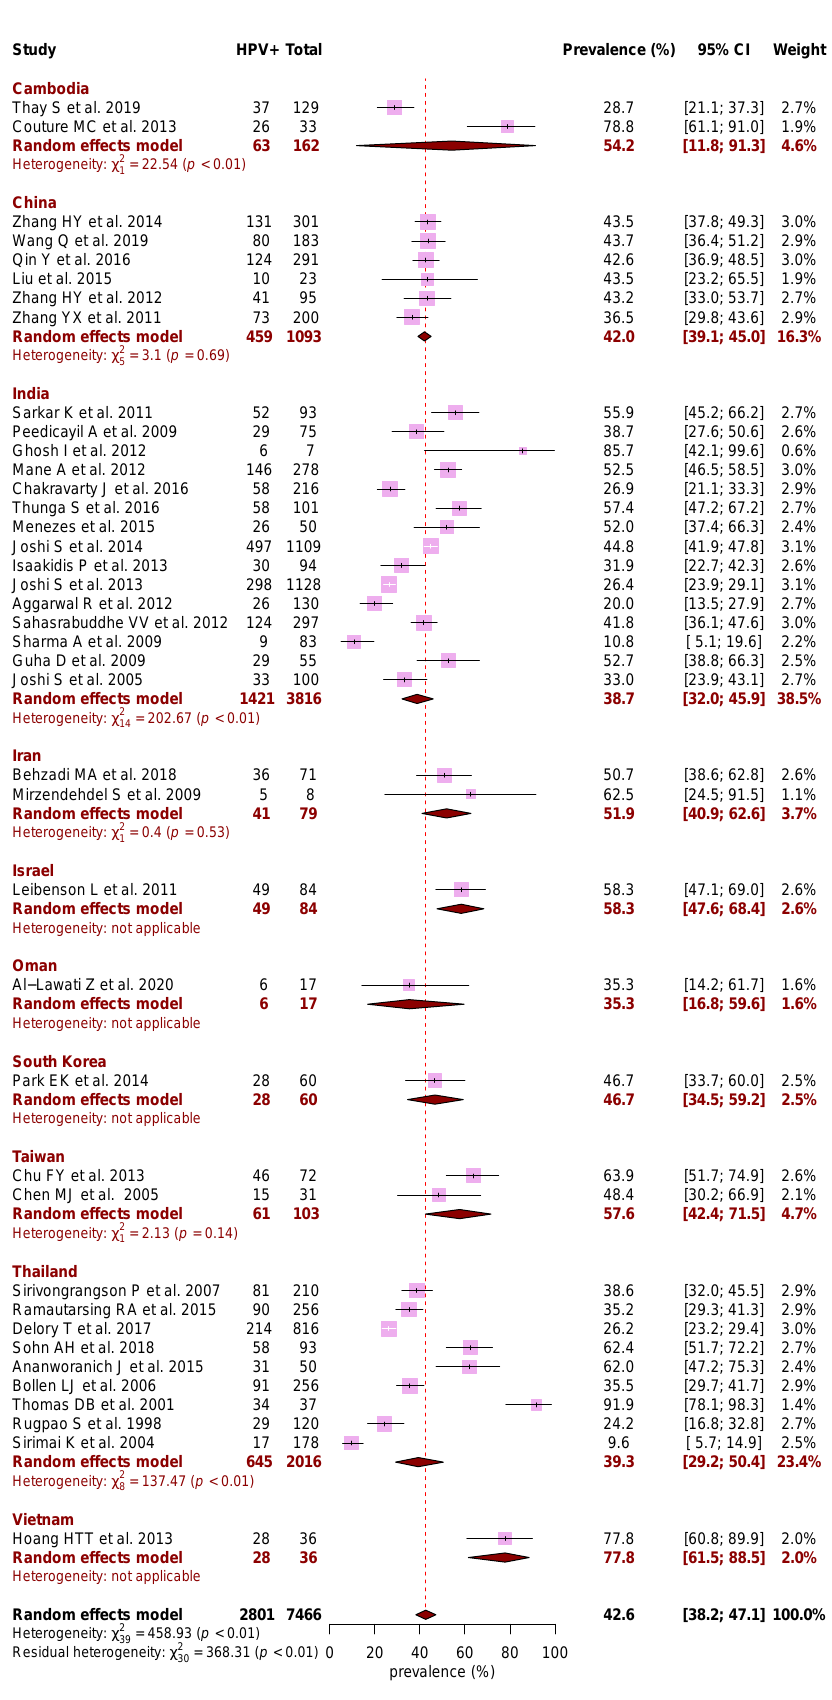
Figure 2. Forest plot of HPV prevalence across countries in Asia. Meta-analyses with random-effects models. HPV: human papillomavirus; CI: confidence